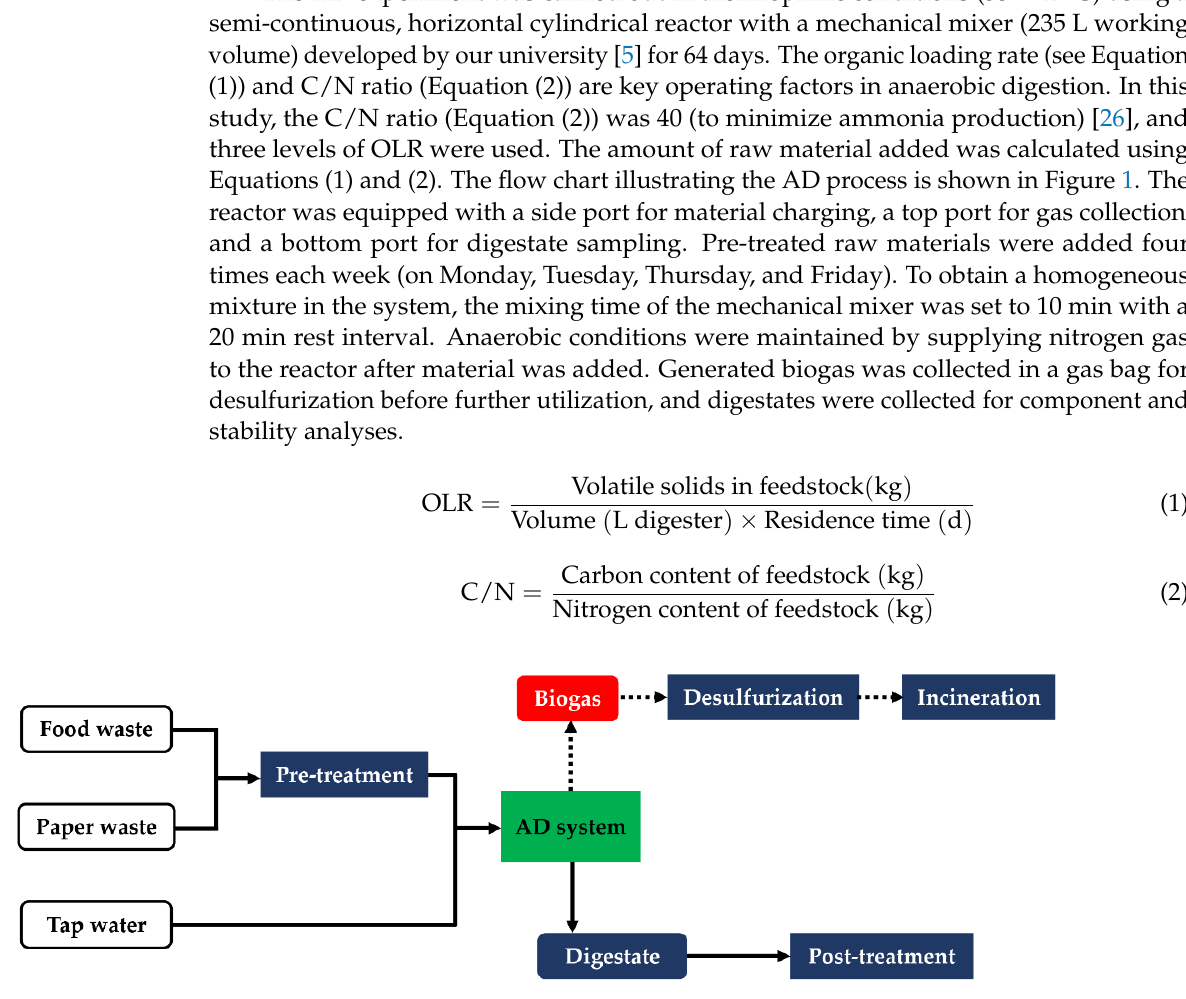
Figure 2. Materials charging plan and operating factors of this study. 2.3. Constant Condition Derivation of Digestate TS Content The adjustment of digestate TS content was applied by adding tap water. The mass of tap water to be added was calculated according to the mass balance of the AD system. The solids content k m of digestate during the AD process is expressed by the following expression: